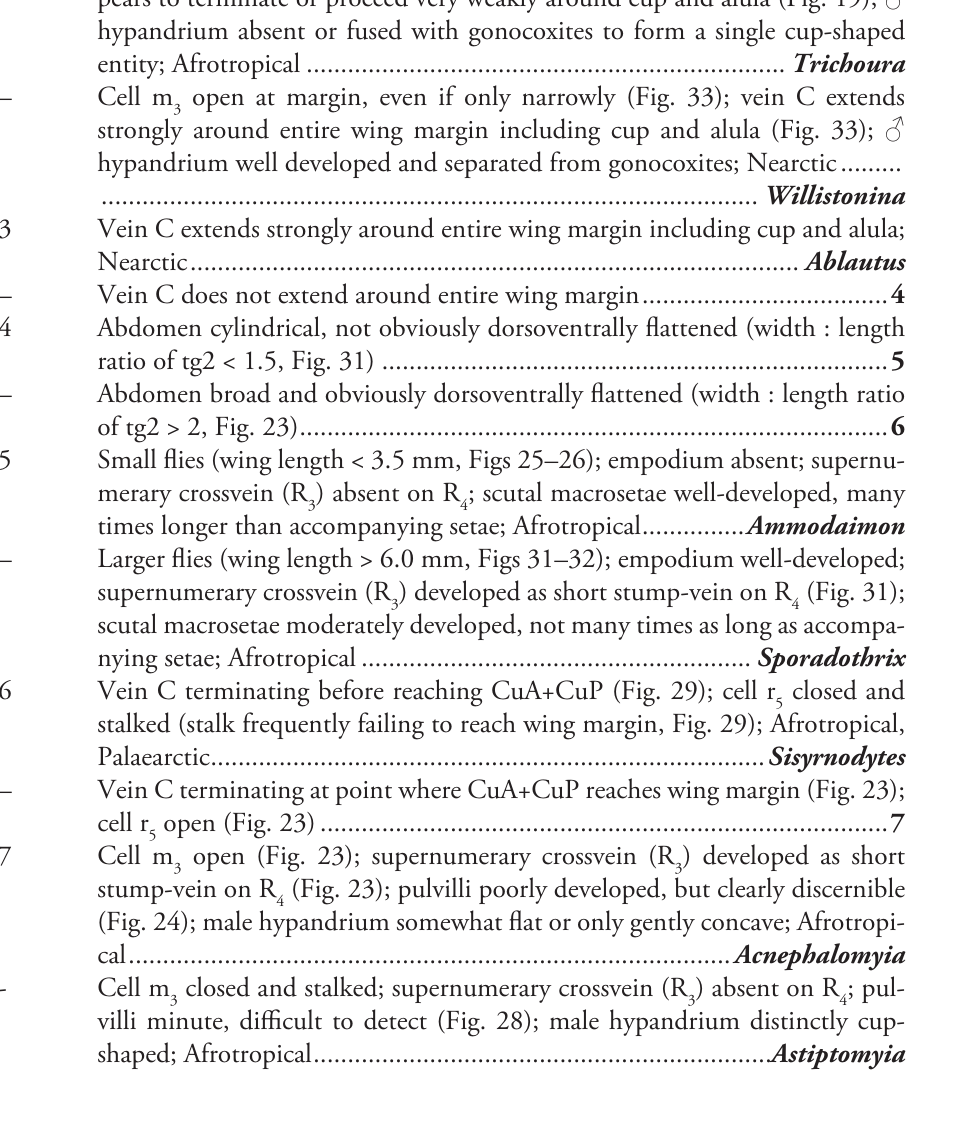
– Cell m open at margin, even if only narrowly (Fig. 33); vein C extends 3 strongly around entire wing margin including cup and alula (Fig. 33); ♂ hypandrium well developed and separated from gonocoxites; Nearctic ......... 3 Vein C extends strongly around entire wing margin including cup and alula; – Vein C does not extend around entire wing margin .................................... 4 4 Abdomen cylindrical, not obviously dorsoventrally flattened (width : length ratio of tg2 < 1.5, Fig. 31) .......................................................................... 5 – Abdomen broad and obviously dorsoventrally flattened (width : length ratio of tg2 > 2, Fig. 23) ...................................................................................... 6 5 Small flies (wing length < 3.5 mm, Figs 25–26); empodium absent; supernu- merary crossvein (R ) absent on R ; scutal macrosetae well-developed, many 3 4 times longer than accompanying setae; Afrotropical ............... Ammodaimon – Larger flies (wing length > 6.0 mm, Figs 31–32); empodium well-developed; supernumerary crossvein (R ) developed as short stump-vein on R (Fig. 31); 3 4 scutal macrosetae moderately developed, not many times as long as accompa- nying setae; Afrotropical ......................................................... Sporadothrix 6 Vein C terminating before reaching CuA+CuP (Fig. 29); cell r closed and 5 stalked (stalk frequently failing to reach wing margin, Fig. 29); Afrotropical, Palaearctic ................................................................................. Sisyrnodytes – Vein C terminating at point where CuA+CuP reaches wing margin (Fig. 23); cell r open (Fig. 23) ................................................................................... 7 5 7 Cell m open (Fig. 23); supernumerary crossvein (R ) developed as short 3 3 stump-vein on R (Fig. 23); pulvilli poorly developed, but clearly discernible 4 (Fig. 24); male hypandrium somewhat flat or only gently concave; Afrotropi- - Cell m closed and stalked; supernumerary crossvein (R ) absent on R ; pul- 3 3 4 villi minute, difficult to detect (Fig. 28); male hypandrium distinctly cup- shaped; Afrotropical ................................................................... Astiptomyia